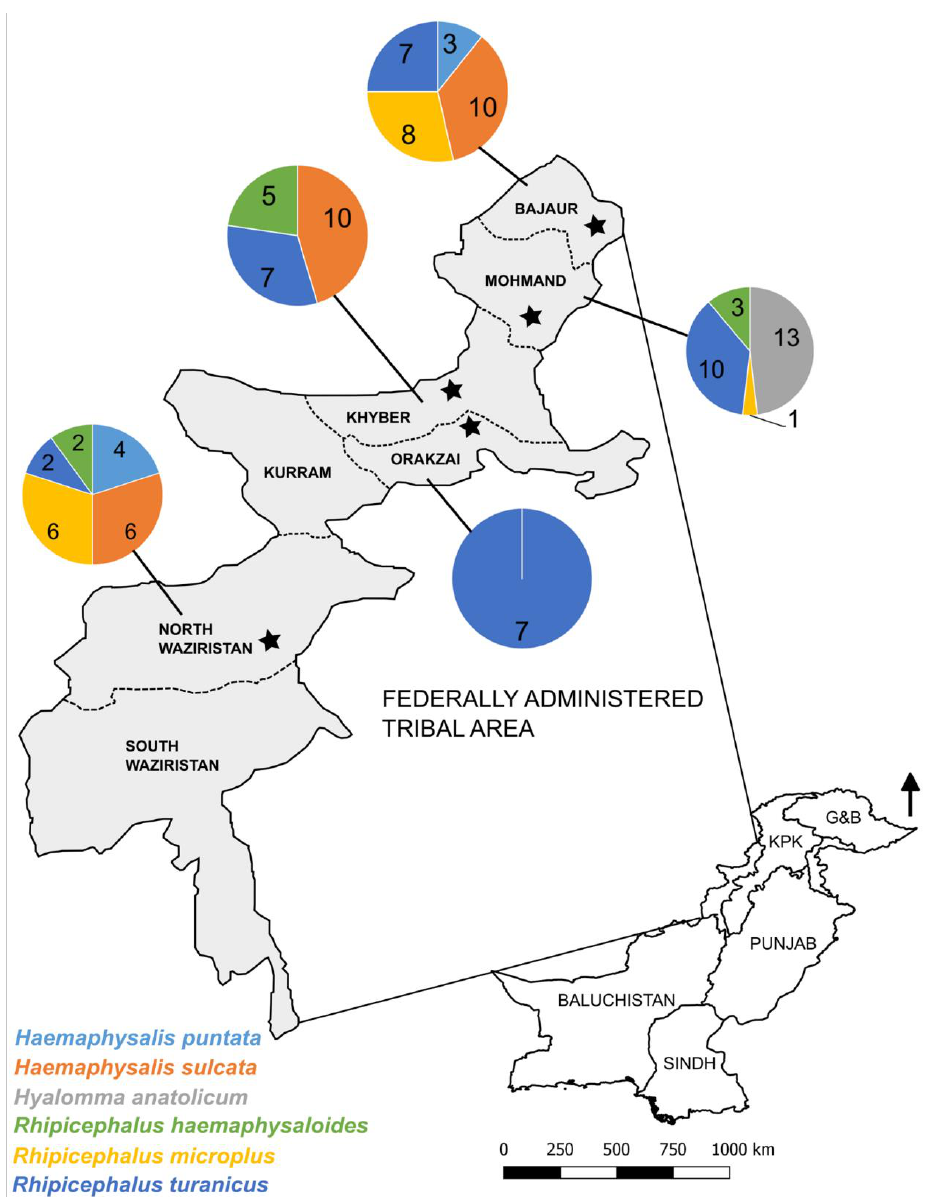
Figure 1. Map of Pakistan (bottom right) and the Federally Administered Tribal Area (FATA) (grey-colored areas on top left) showing the tribal districts (starred) included in this study. Different colors in each pie chart indicate the distribution of tick species identified from each district.